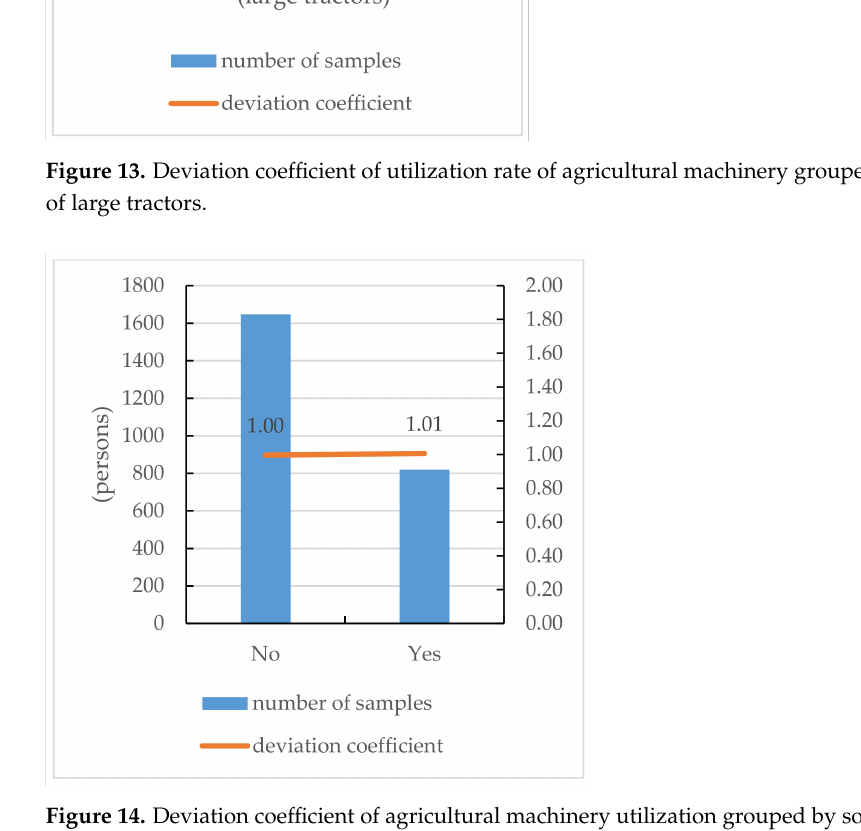
Figure 14. Deviation coefficient of agricultural machinery utilization grouped by socialized